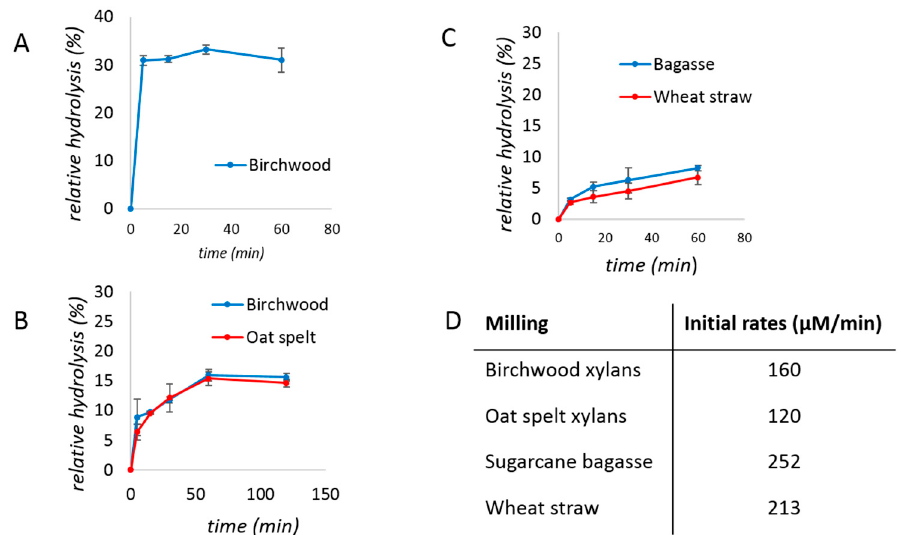
Figure 2. Studies of xylanase reaction kinetics under milling for ( A and B ) birchwood (blue) and oat spelt (red) xylans, or ( C ) sugarcane bagasse (blue) and wheat straw (red). ( A ) the reaction mixture contained 200 mg of birchwood xylan, 500 mg of the commercial xylanase mixture (i.e., 0.2 mg of protein or 0.1% w / w ), and 150 µ L of water. ( B ) the mixtures contained 200 mg of birchwood or oat spelt xylan, 10 mg of the commercial xylanase mixture (i.e., 0.04 mg of protein or 0.02% w / w ), and 150 µ L of water. ( C ) the reaction mixtures contained 400 mg of substrate, 20 mg of the commercial xylanase mixture (i.e., 0. 0.08 mg of protein or 0.02% w / w ), and 600 µ L of water. ( D ) Initial rates calculated for the reactions of panels B and C. Reactions were performed in triplicates and the error bar is the standard deviation.